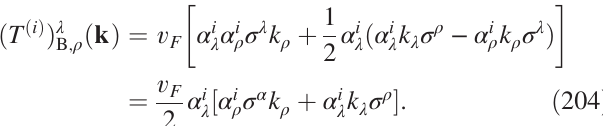
FIG. 2. Contour plot of the density η H symmetric Chern insulator. The plot is shown with the hopping parameters t ¼ t 0 ¼ 20 , m ¼ 0 . 25 , and r ¼ 1